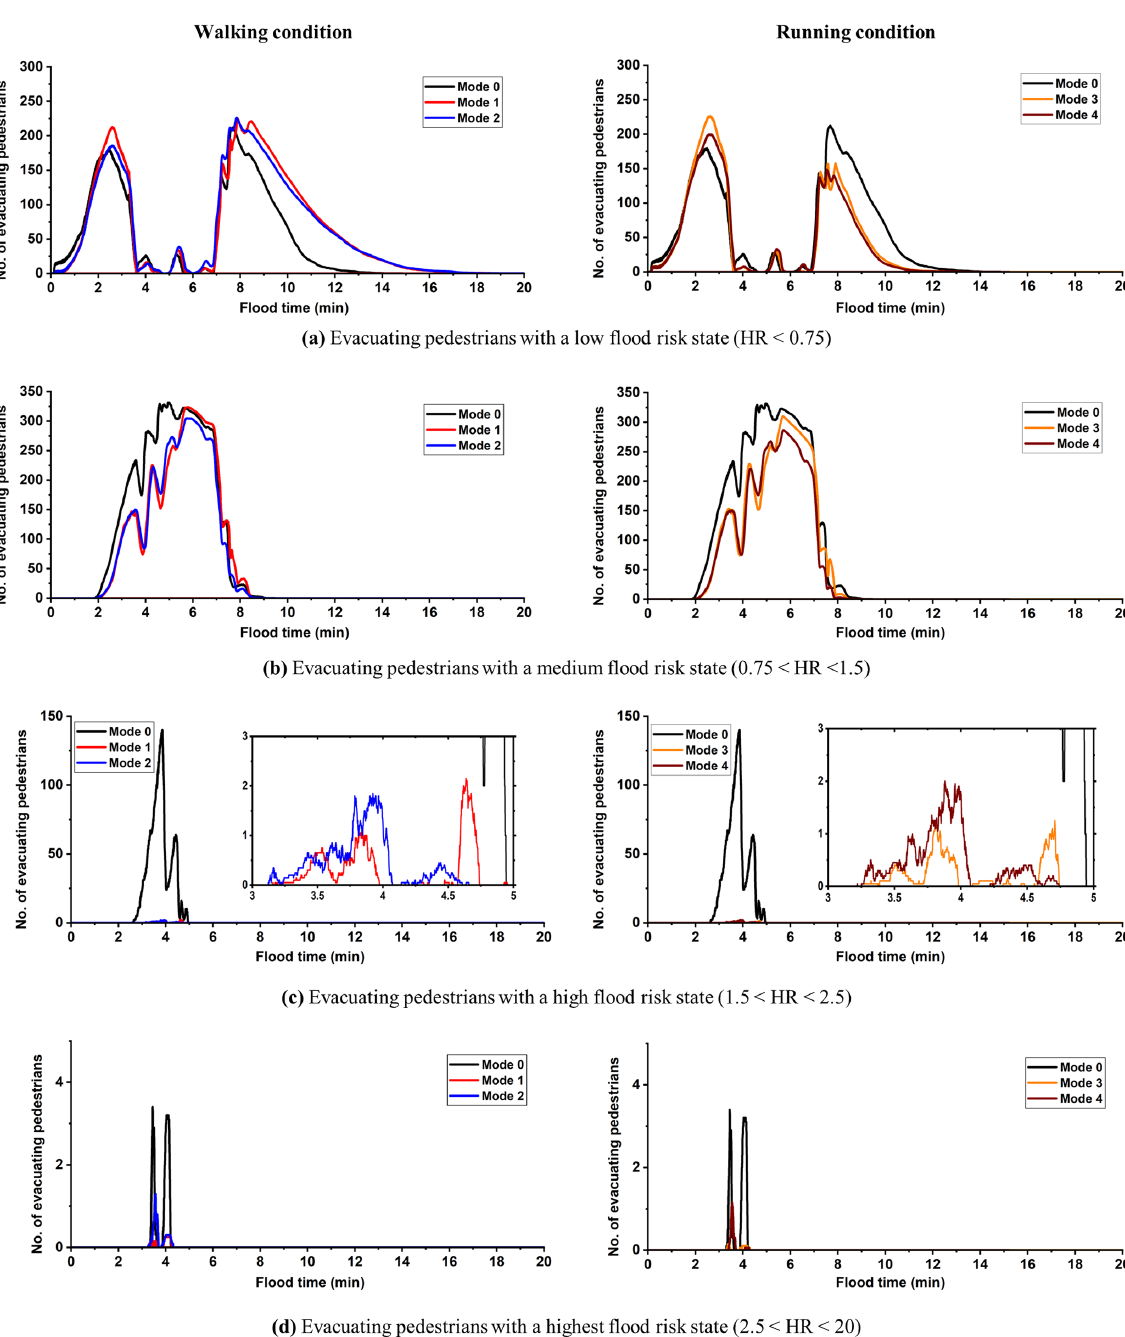
Figure 4. Average number of evacuating pedestrians with different HR-related flood risk states predicted by the simulator after 20 runs under Mode 0 (baseline outcomes from the previous version of the simulator; Shirvani et al., 2020); Mode 1 or Mode 2 (age-related walking condition for the moving speeds without or with the two-way interaction condition); and Mode 3 or Mode 4 (age-related running condition for the moving speeds without or with the two-way interaction condition). Analysis is presented in panels (a) – (d) , each considering a different flood risk